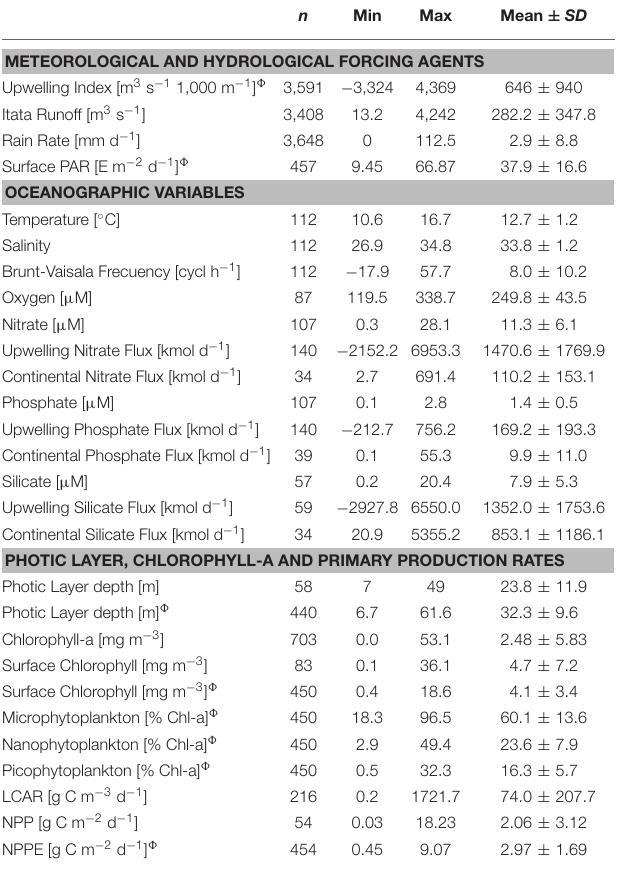
FIGURE 2 | Mean climatology for Upwelling Index (A) , Itata Runoff (B) , Precipitation Rate (C) , and Surface PAR (D) . Markers indicate monthly mean values; the shaded area represents monthly 95% confidence